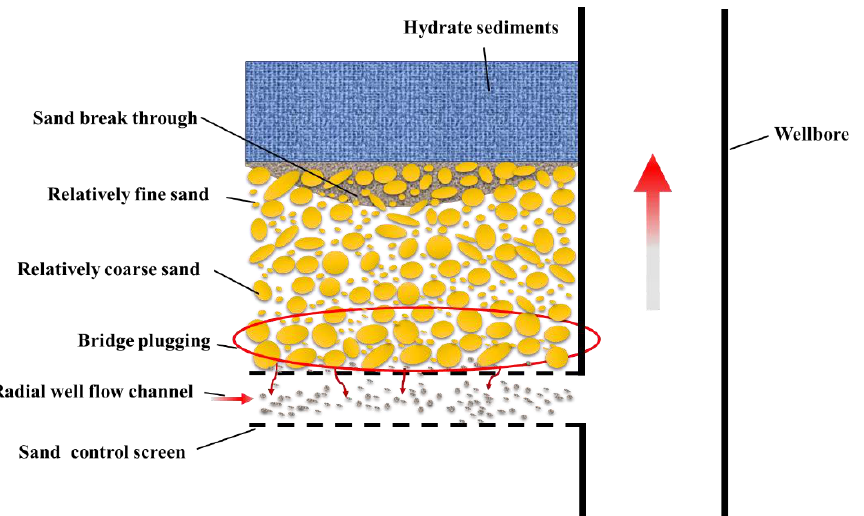
Figure 15. Mechanism diagram of radial well depressurization development combined with sand- control screen and gravel packing.